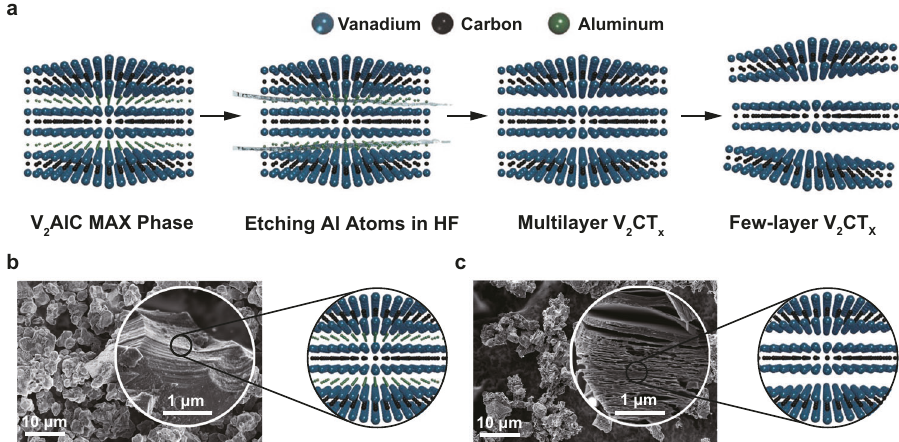
Fig. 2 Synthesis and characterization of V 2 AlC MAX and V 2 C MXene. a Schematic diagram of selective etching and interlayer expansion route to fabricate V 2 C MXene from the parent V 2 AlC MAX phase. b FESEM images (Inset depicts the corresponding high-magni fi cation SEM image) and structural model of V 2 AlC before HF treatment, displaying a typical compact layer structure. c FESEM images (Inset depicts the corresponding high-magni fi cation SEM image) and structural model of V 2 AlC after HF treatment to fabricate multilayer V 2 C MXene with a typical exfoliated layer topology. A representative image of three replicates from each group is shown.